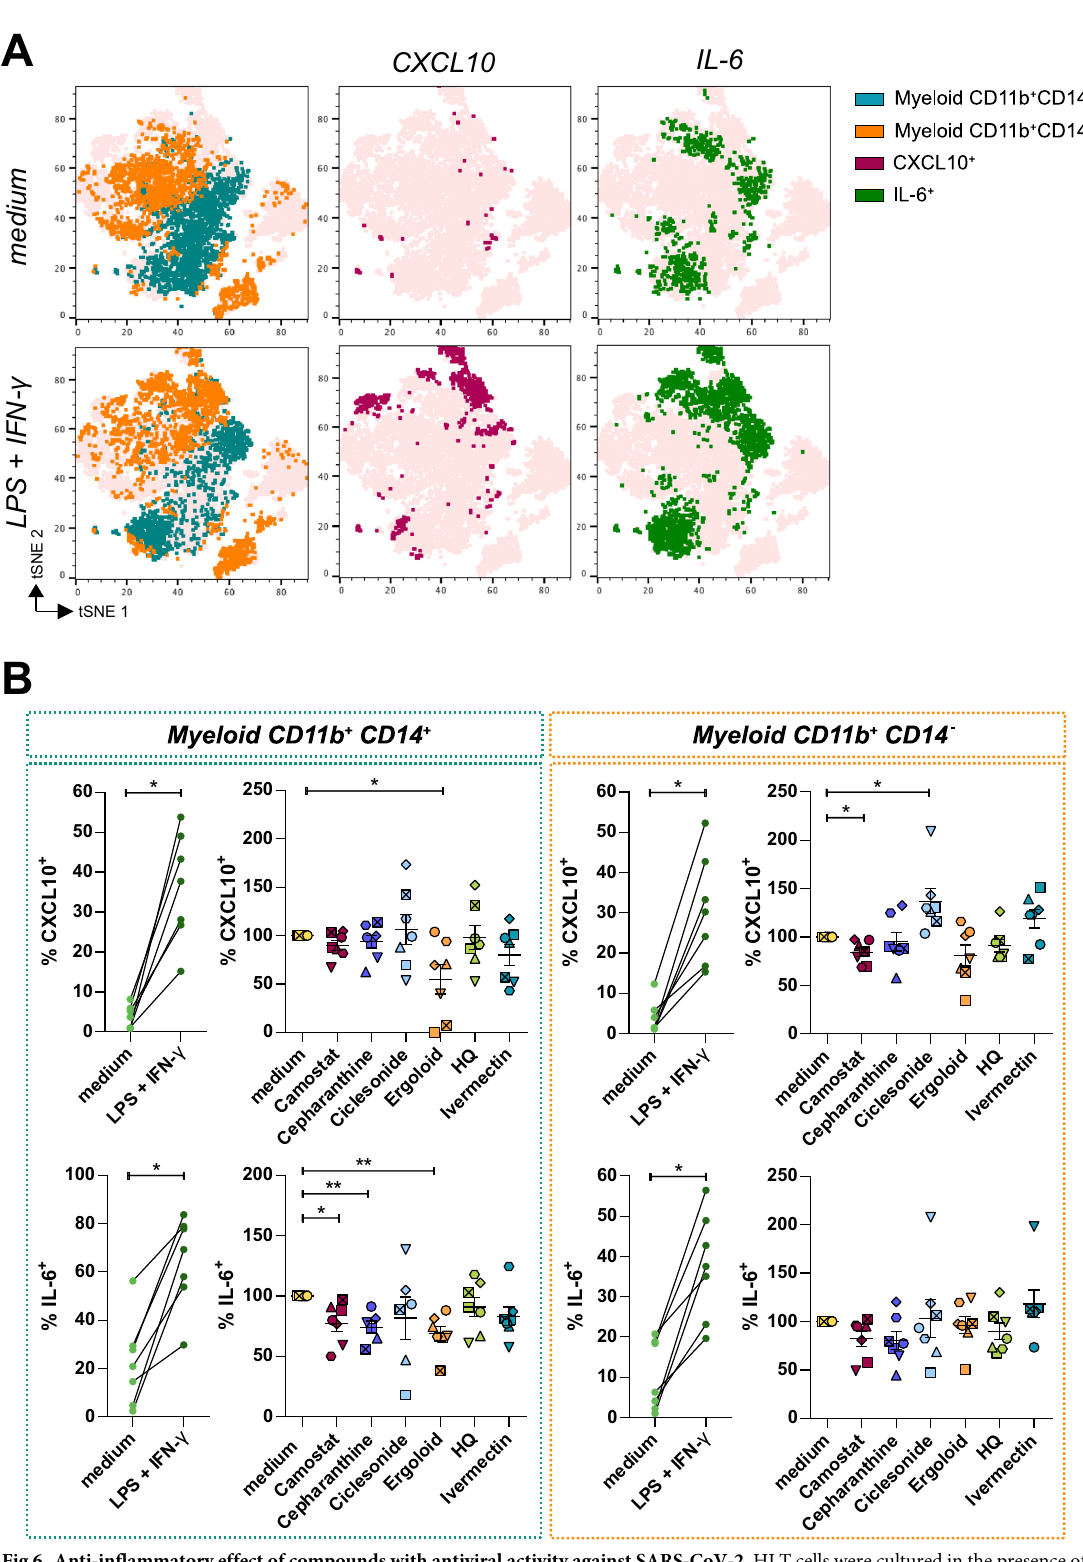
Fig 6. Anti-inflammatory effect of compounds with antiviral activity against SARS-CoV-2. HLT cells were cultured in the presence of 20 μ M of camostat, cepharanthine, ciclesonide, ergoloid, hydroxychloroquine (HQ) and ivermectin, alone or in combination with the